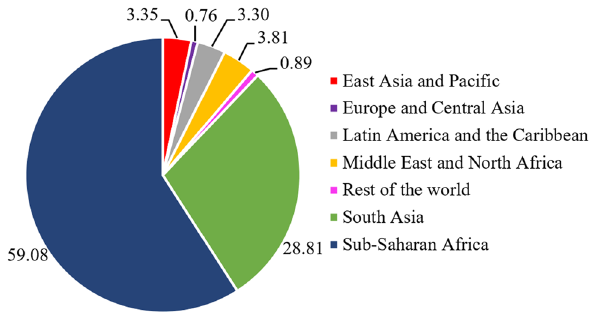
Fig. 2 Regional share of people living below poverty line